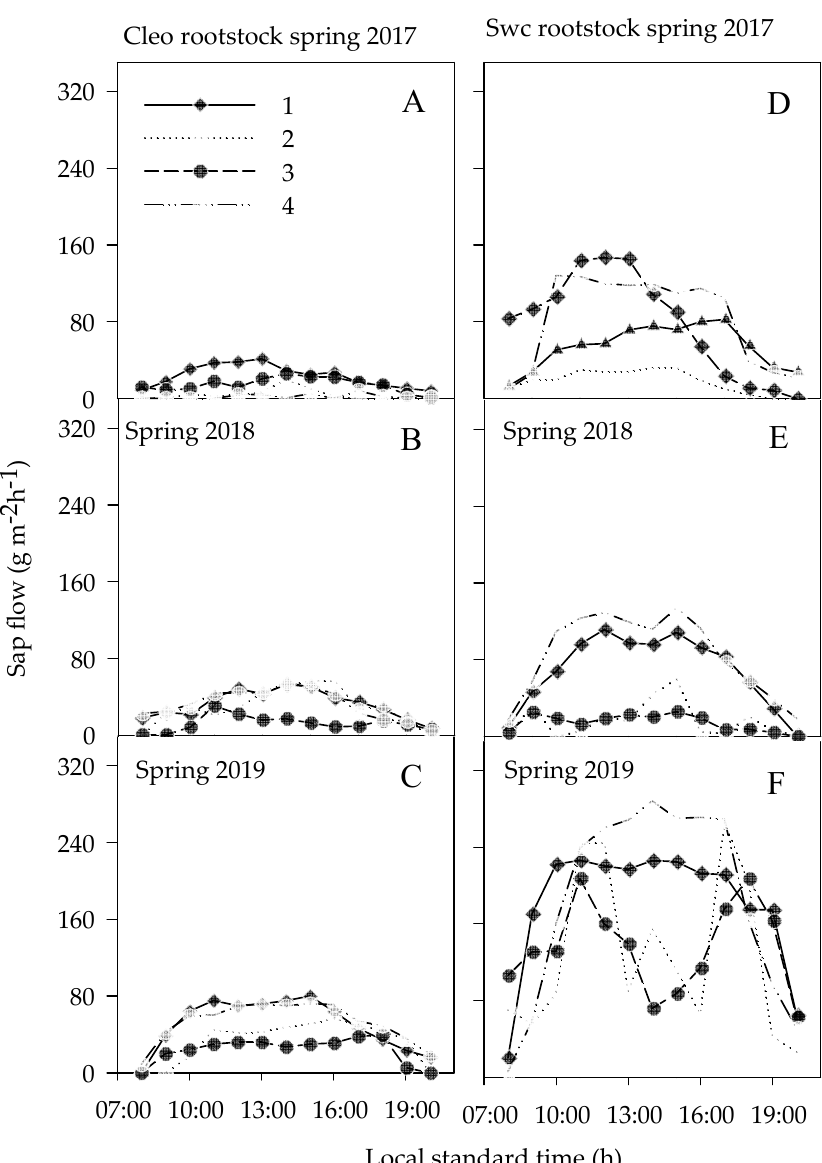
Figure 2. Sap flow of Huanglongbing (HLB)-affected Hamlin citrus trees budded on Cleopatra ( A – C ) and Swingle ( D – F ) rootstocks during April–May 2017, 2018, and 2019 at Southwest Florida Research and Education Center near Immokalee, FL. Treatments: Control (1), full Ca dose (2), full Mg dose (3), and half Ca and half Mg doses (4), (full dose = 45 kg ha − 1 ).